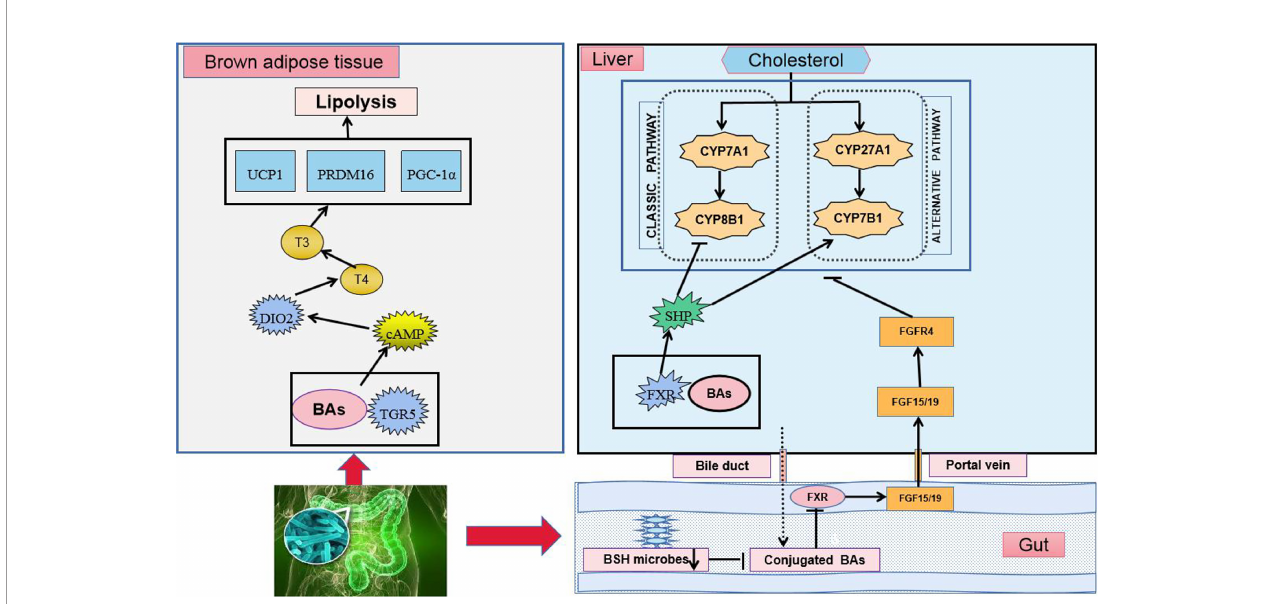
FIGURE 2 | BAs regulate TGR5 and FXR in lipid-metabolism disorder. Cholesterol regulates the synthesis of BAs and completes the circulation of the liver and intestine through two